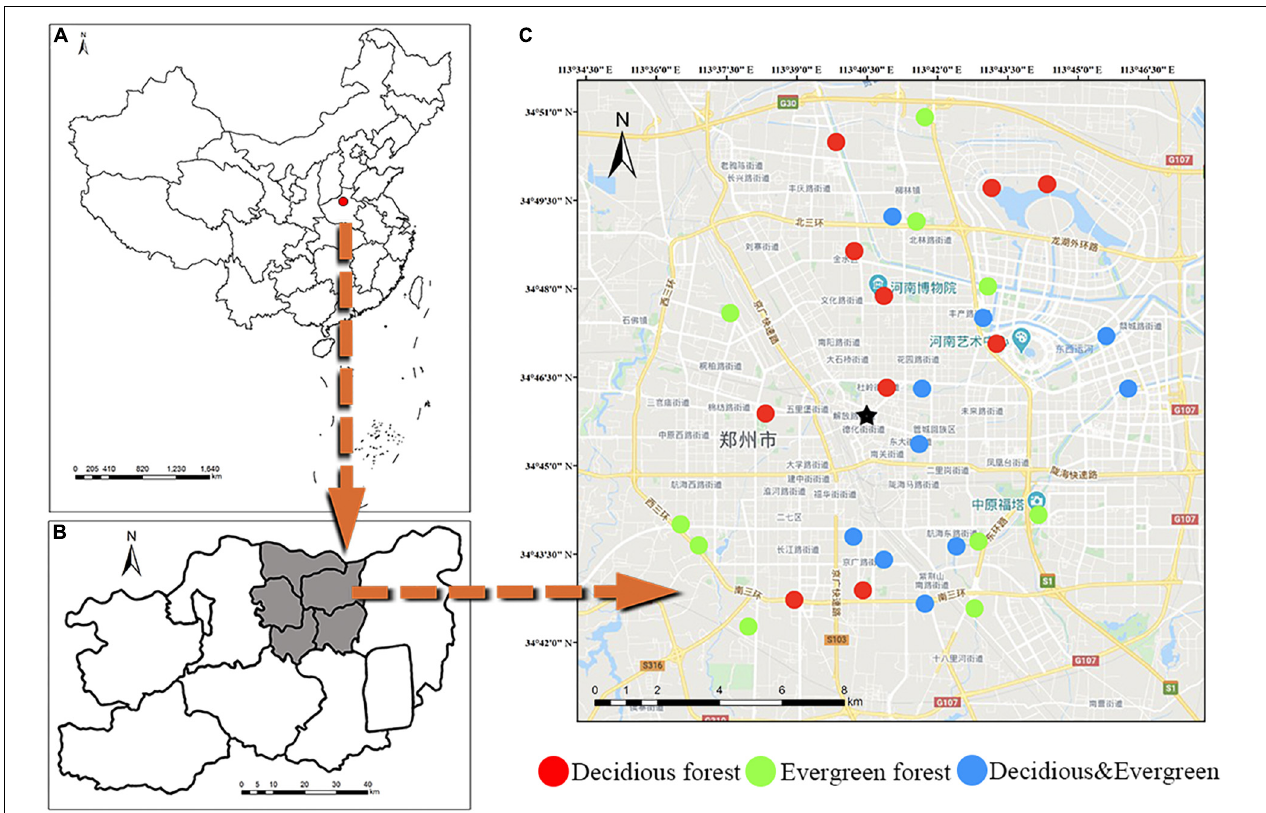
FIGURE 1 | Study area and location of sample plots. General location (A) of the study area within Zhengzhou, China; location of all plots (B) and detailed view of an example of plots and stands (C)